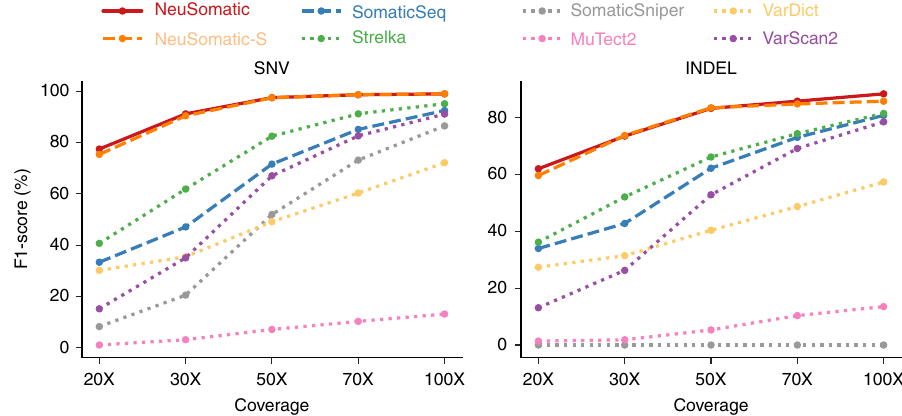
Fig. 6 Performance analysis of the sequence coverage impact on the whole-exome sample mixture dataset. In this example, tumor has 50% purity and normal has 95% purity. Y -axis illustrates the highest F1-score achieved by each algorithm for sample alignments coverages ranging from 20× to 100×